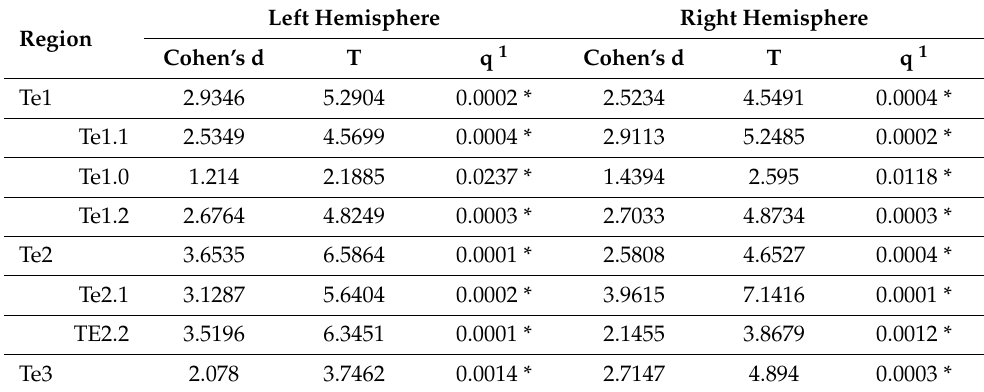
Table 1. Changes in region-specific volumes between immediate and late postpartum.